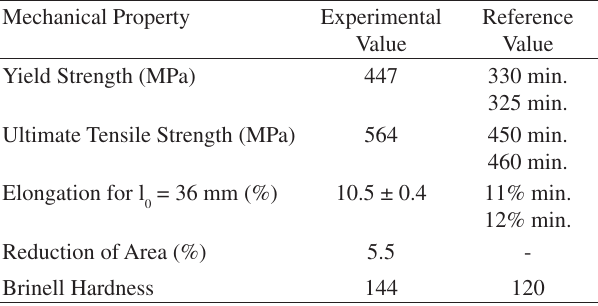
Table 2. Mechanical properties of D16T alloy.